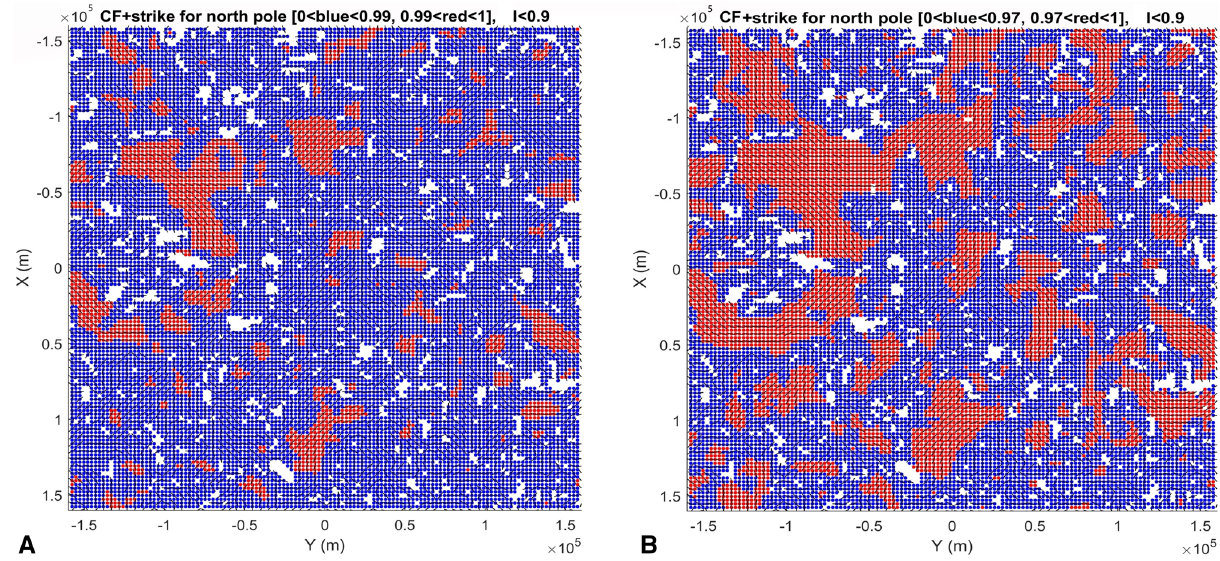
Figure 3. Stability of the comb factor (CF) within the area of north pole of the Moon. Dimensions are in meters. ( A ) Left panel corresponds to the strike angle plot and its CF for the north pole in Fig. 2A. The CF between 0.99 and 1.00 is in red color while the lower CF is in blue color. ( B ) Right panel shows CF between 0.97 and 1.00 in red color while the lower CF is in blue (blue symbol is larger for contrast clarity). Both plots are strike angles for ratio I < 0.9 (see Eq. 2), sensitive to weakness directions of the rocks in subsurface structures near the north pole of the Moon. Data were plotted using MATLAB software.